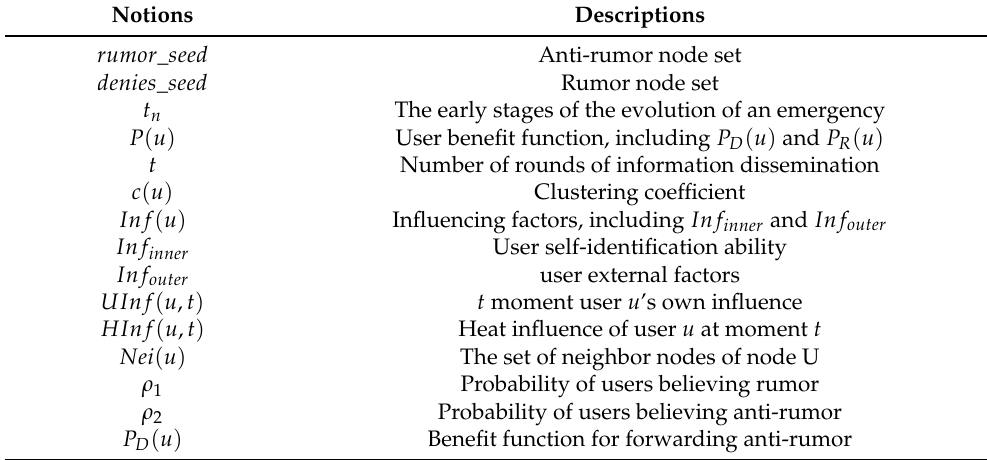
Table 1. Notations used in this